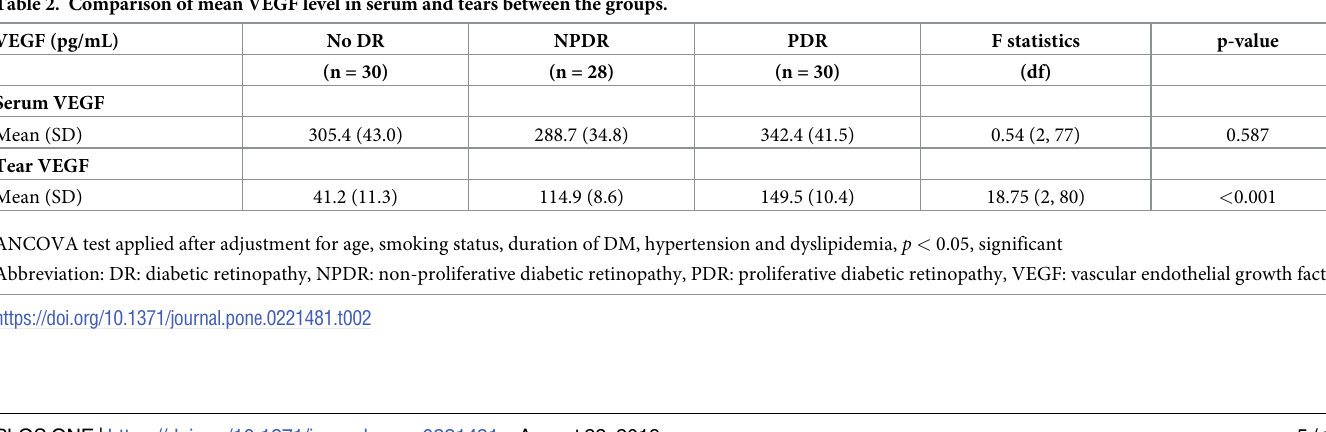
Among type 2 DM patients, the NPDR and PDR groups showed a higher mean level of VEGF in tears (114.9 SD 8.6 pg/mL and 149.5 SD 10.4 pg/mL) compared to the no DR group (41.2 SD 11.3 pg/mL). There was a significant difference of mean tear VEGF levels between the three groups ( p < 0.001) after adjusting for age, smoking status, duration of DM and systemic illness (hypertension and dyslipidaemia) (Table 2). After the Bonferroni post-hoc analysis, there was a significant mean difference of tear VEGF levels between the no DR and NPDR groups ( p < 0.001) and between the no DR and PDR groups ( p < 0.001) (Table 3). The associated factors of serum and tear VEGF levels are summarised in Table 4. Age, dura- tion of DM, severity of DR and VEGF levels were the significant variables among the associ- ated factors with p- value < 0.25 based on simple linear regression. The four significant